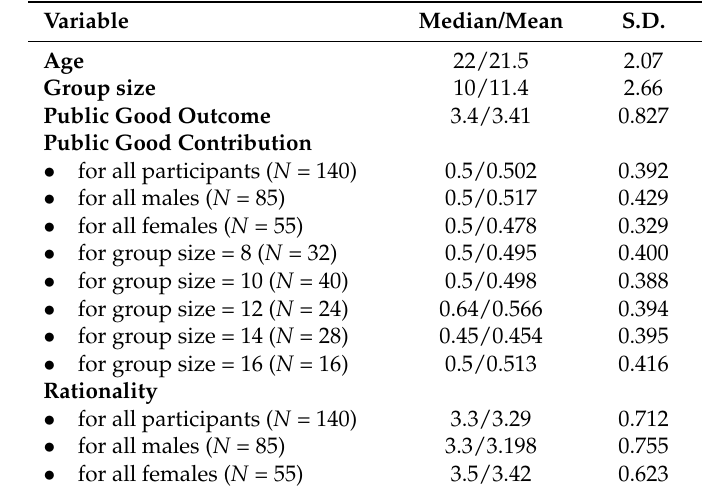
Table 1. Summary statistics.